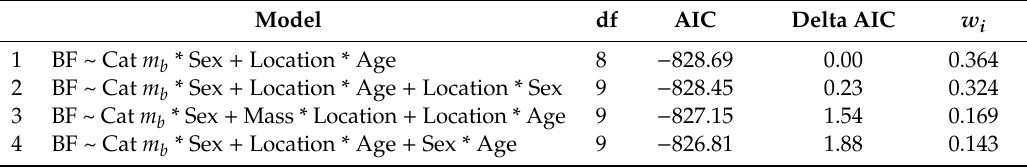
Table 2. Summary of generalised linear modelling testing for factors influencing bite force in stray and feral cats ( Felis catus ) in southwest Western